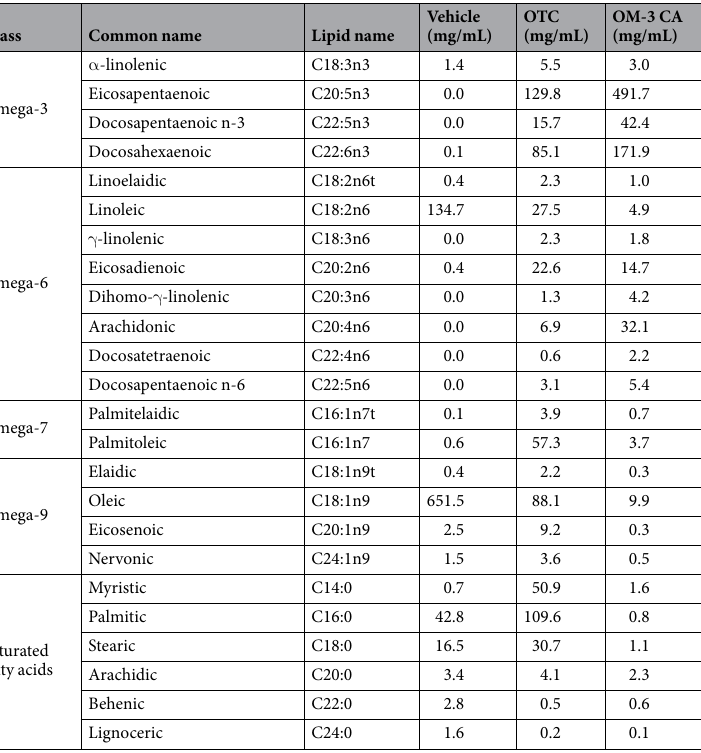
Table 1. Fatty acid profile of vehicle and dosing solutions. OM-3 CA: omega-3-carboxylic acids; OTC, over-